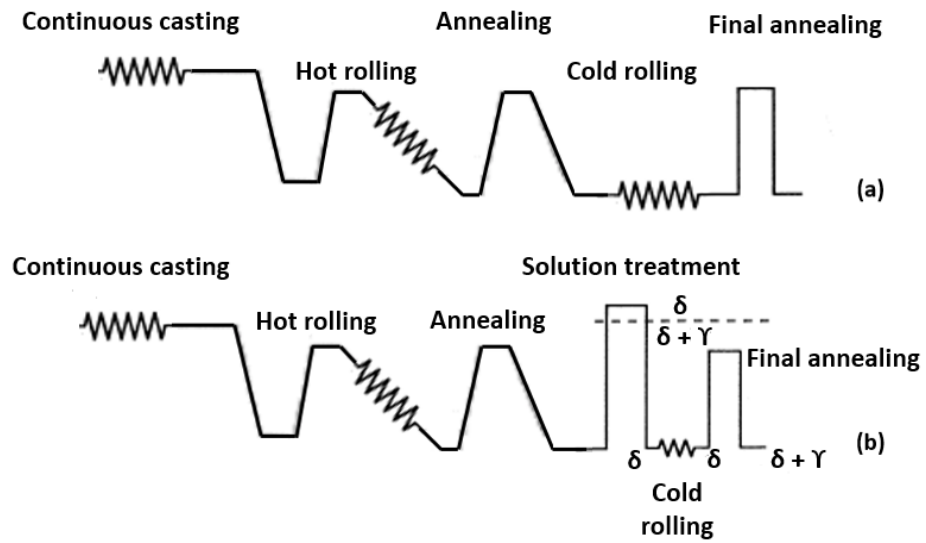
Figure 1. Schematic illustration of the two types of thermomechanical treatments leading to the formation of microduplex structure in duplex stainless steel. ( a ) Industrial processing and ( b ) thermomechanical treatment described by Maki et al. [6].